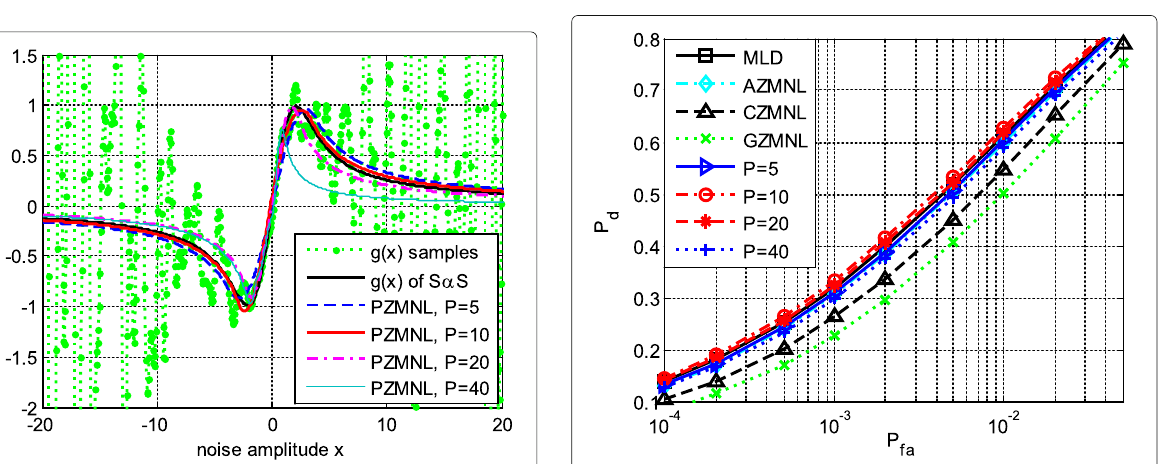
10 − 3 × [0.8,1.2,1.3,0.8,0.9,1.0,1.0,1.0] for the detectors from top to